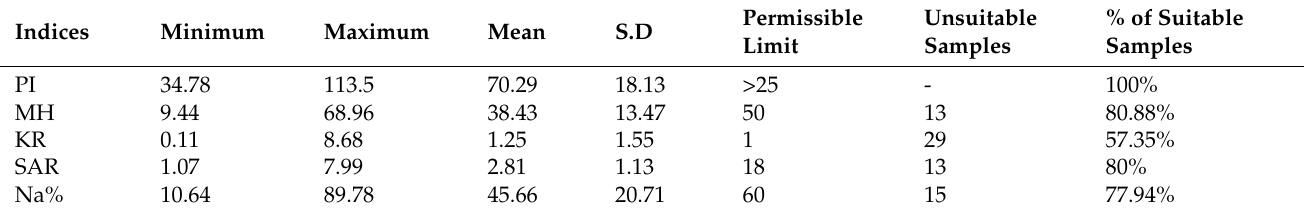
Table 5. The statistical summary of irrigation indices.